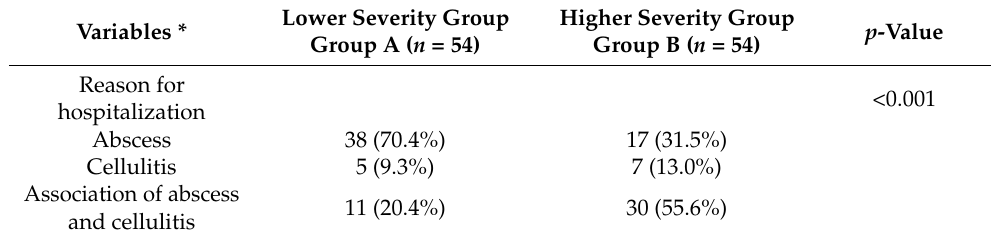
Table 3. Comparison of infection characteristics among patients with odontogenic